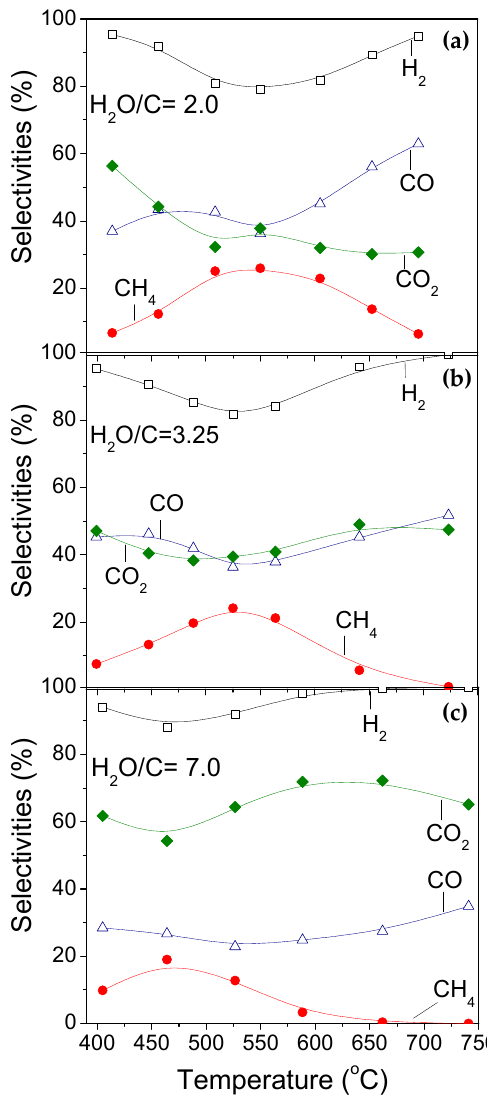
Figure 3. Effect of H 2 O/C ratio on the selectivities toward reaction products obtained as a function of reaction temperature over 0.5%Rh/TiO 2 catalyst. ( a ) H 2 O/C = 2; ( b ) H 2 O/C = 3.25; ( c ) H 2 O/C = 7. Experimental conditions: the same as in Figure 2.